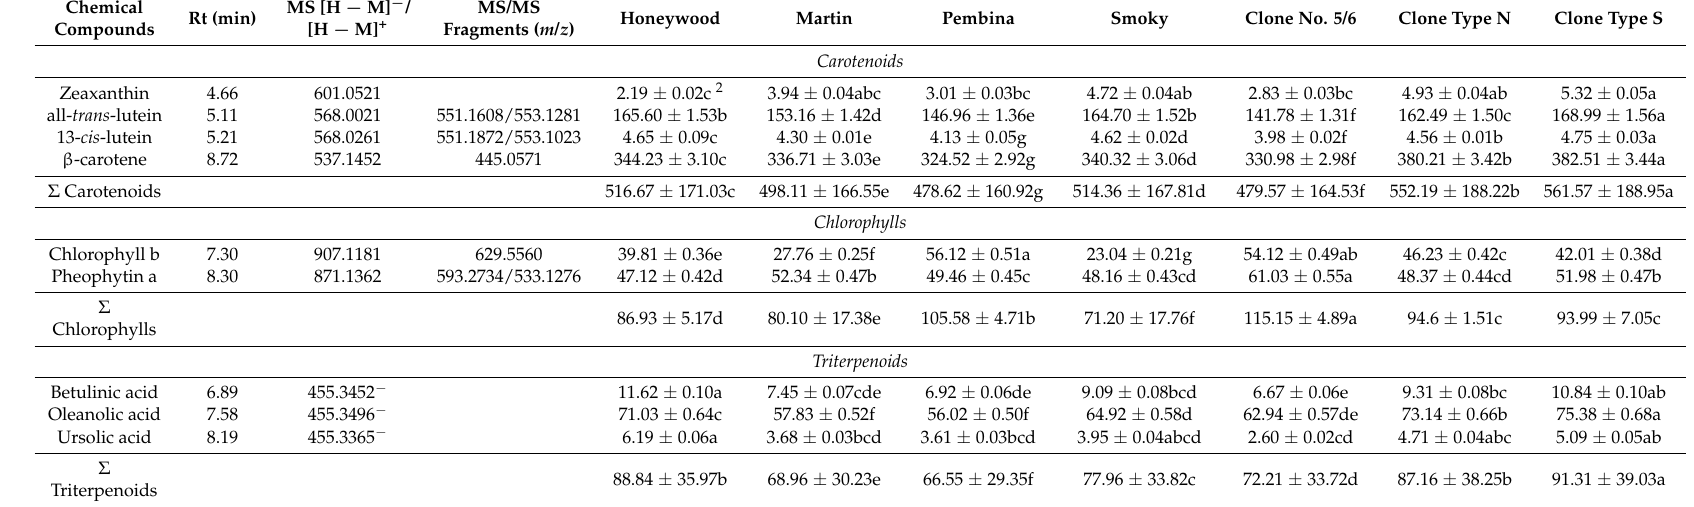
Table 3. The fruit content of carotenoid, chlorophyll, and triterpenoid compounds (mg/kg of dm) 1 in seven Saskatoon genotypes analyzed in